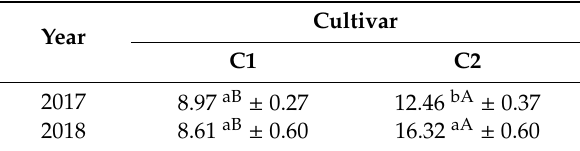
Table 5. Mean values ± standard error and significant di ff erences of the Fisher’s LSD test ( α = 0.05) for number of capitula for the factor year (2017 and 2018) and cultivar (C1 and C2). Mean values with at least one identical lowercase letter are not significantly di ff erent within a column. Mean values with at least one identical capital letter are not significantly di ff erent within a